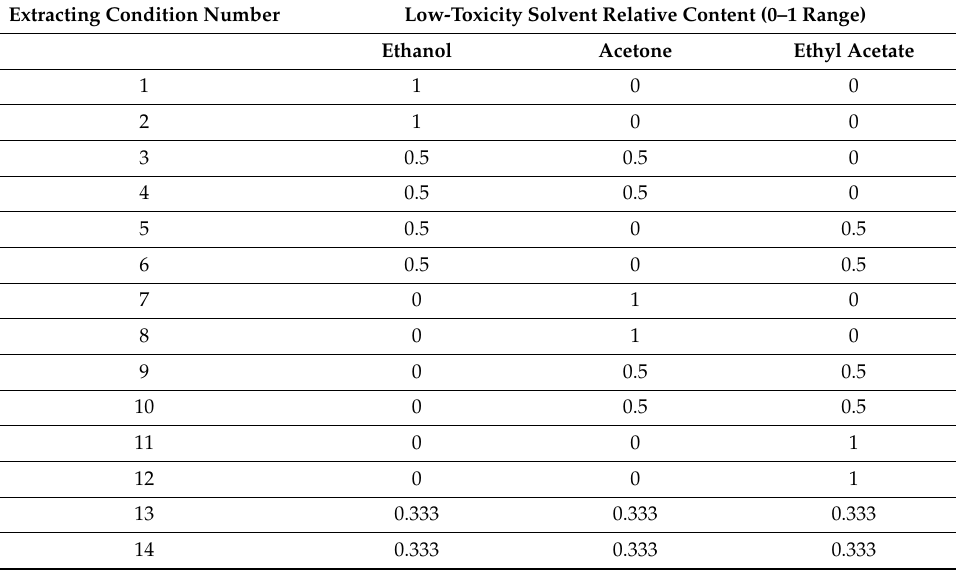
Table 1. Description of the different low-toxicity solvent systems applied for lipid extraction of lyophilised squid by-products according to the simplex-lattice mixture